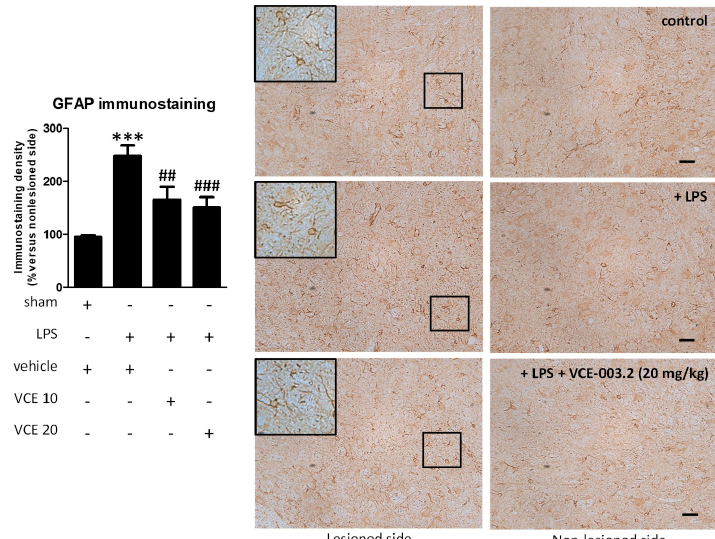
Figure 5. Intensity of the immunostaining for GFAP measured in a selected area of the substantia nigra pars compacta of control and LPS-lesioned mice orally treated for 28 days after lesion with vehicle (corn oil) or VCE-003.2 at the doses of 10 (VCE 10) or 20 (VCE 20) mg/kg. Immunoreactivity values are measured in the lesioned side over the non-lesioned side, and correspond to means ± SEM of more than six subjects per group. Data were assessed using the one-way analysis of variance followed by the Bonferroni test (*** p < 0.005 versus vehicle-treated control (sham) mice; ## p < 0.01, ### p < 0.005 versus vehicle-treated LPS-lesioned mice). Representative immunostaining images for sham and LPS-lesioned mice treated with vehicle or VCE-003.2 at 20 mg/kg are shown at right (scale bar = 50 µm), including a specific inlet showing the morphological characteristics of GFAP-labeled cells (2x magnified).